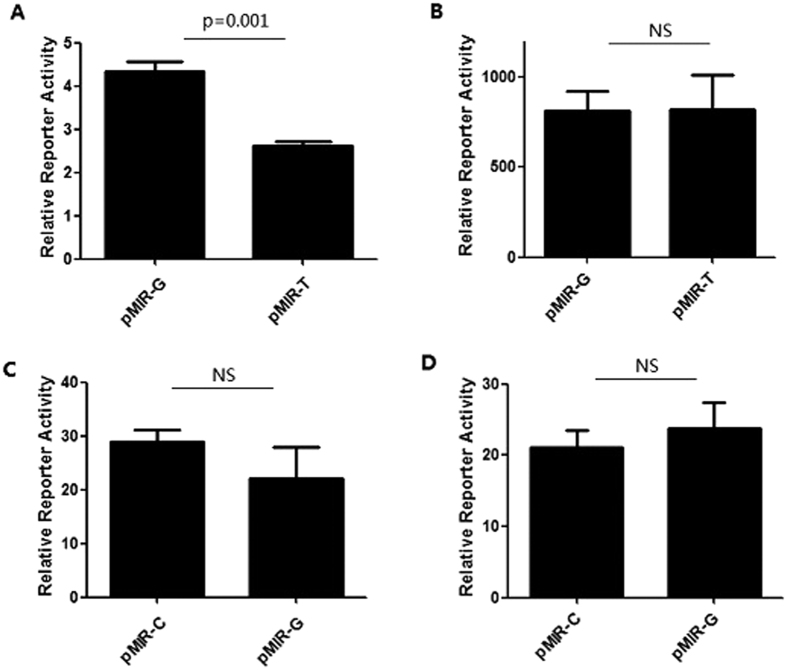
Expression studies of APOC3 3′UTR constructs carrying rs4225G/T (A,B) and rs5128C/G (C,D) alleles in HepG2 cells (A,D) or 293Tcells (B,C), respectively. APOC3 3′UTR activity is expressed as fold change of Relative Luciferase to pMIR basic. Mutant construct was compared with the wild-type construct for each comparison. Values are mean  ±  SE of three independent experiments each corresponding to at least six replicates.